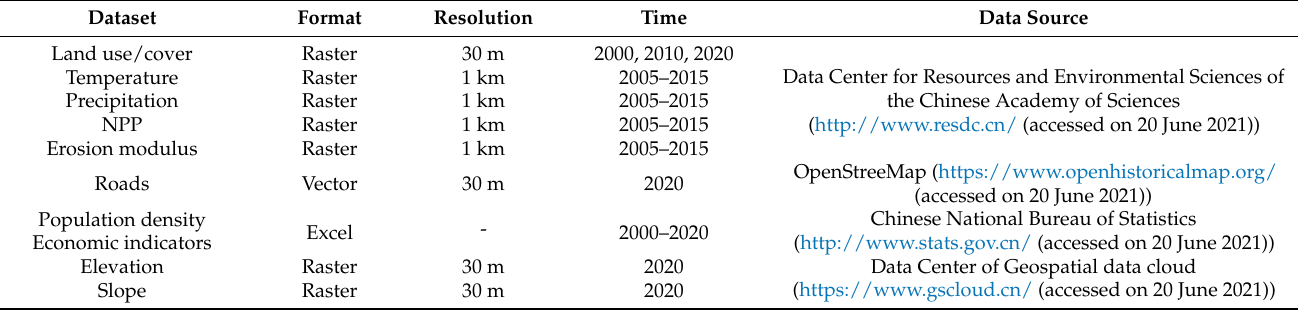
Table 1. Data format and